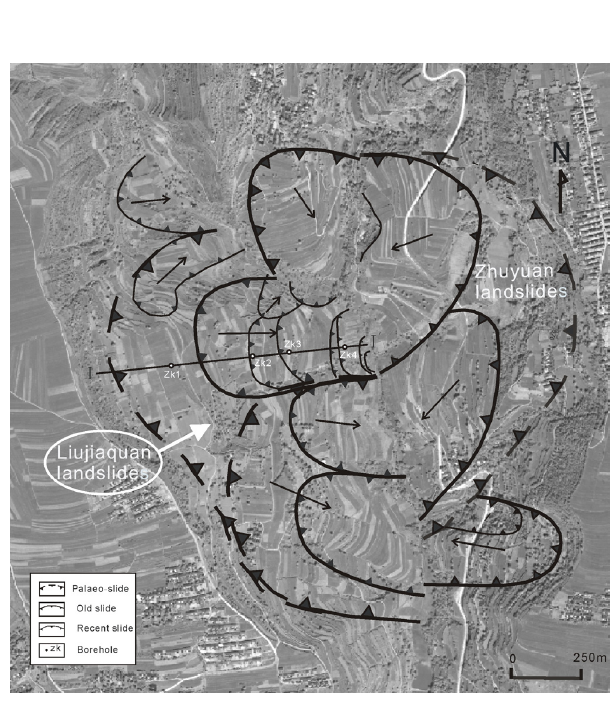
Fig. 3. Representative types of slope failures in the study area.